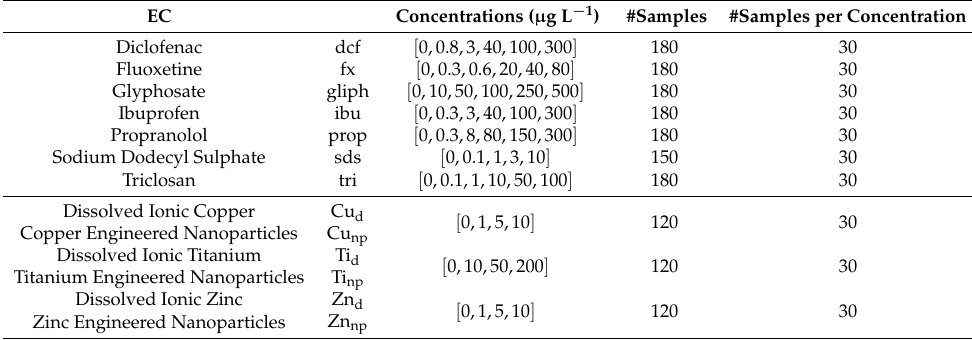
Table 1. OPTOX dataset summary, containing the contaminants, the different concentration values and the distribution of samples among them. The first section of the table includes pharma, pesticides, and personal care products, while the second section includes metals and